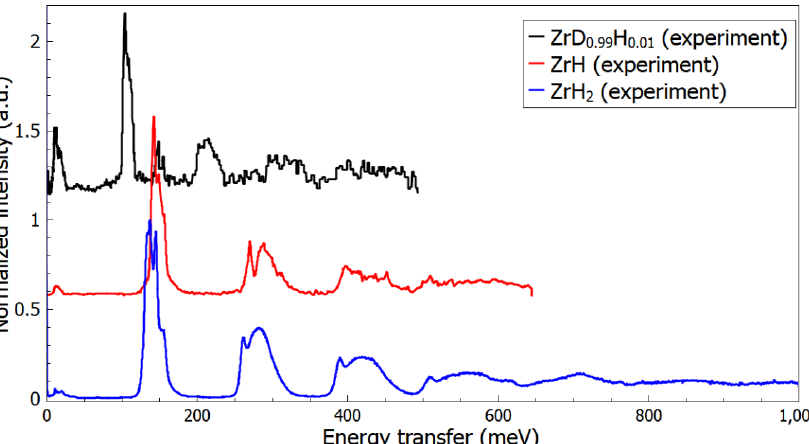
Figure 2. The INS spectra for (cid:15) -ZrH 2 measured with the VISION instrument at 5 K (blue), γ -ZrH (red) at 4.5 K, and γ -ZrD (black) at 30 K, both measured with the TFXA spectrometer. Spectra have been normalized to the same maximum value of the fundamental peaks. It must also be mentioned that the γ -ZrD sample has been contaminated by ∼ 1 at.% H, and also contained α - and δ -phases [13], with the actual ratio of Zr atoms in the different phases as 0.718( α -ZrD 0.001 ) + 0.269( γ -ZrD 0.98 ) + 0.013( δ -ZrD 1.2 ), which results in extra peaks at ∼ 140 meV and higher intensity of the lattice modes (<30 meV) compared to the expected spectrum for pure γ -ZrD. Figures were drawn using the Mantid program